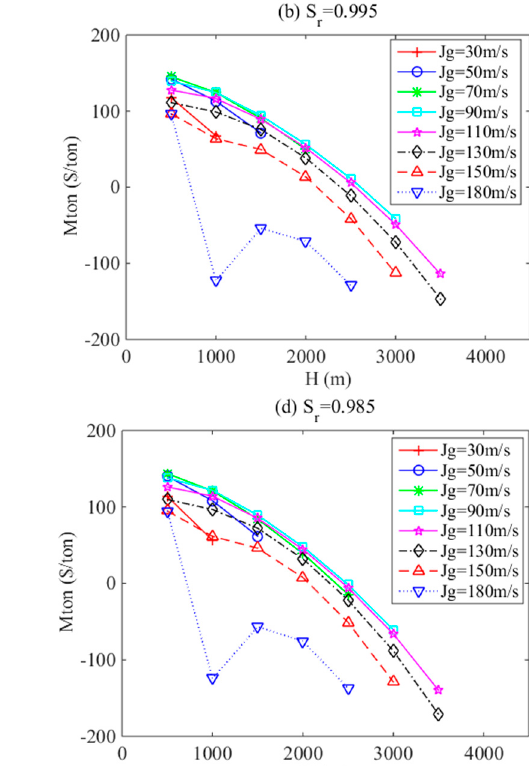
Figure 11. Figure of profitability per tonnage of mineral Mton influenced by submergence ratio S r at different mining depth H and gas flux rate Jg . The submergence ratio of ( a – d ) are 1.000, 0.995, 0.990, 0.985, respectively.